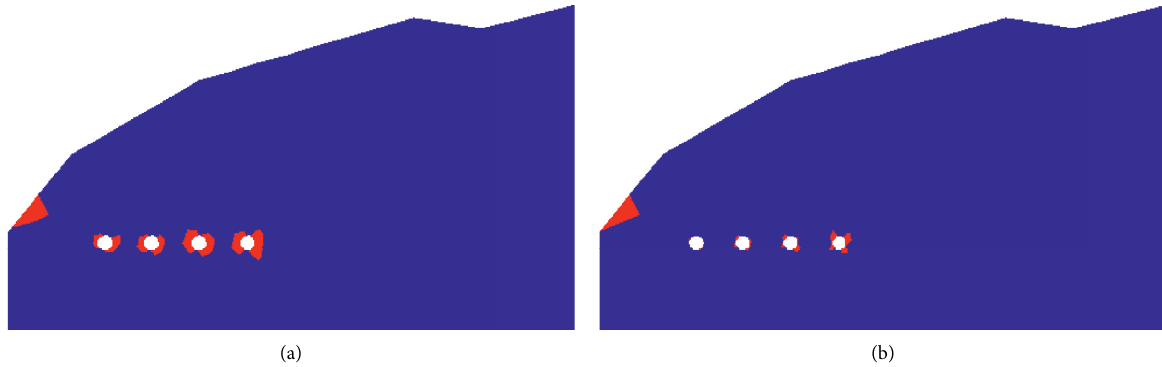
Figure 10: The plastic zone with different support patterns. (a) Without lining after excavation. (b) With lining after excavation.